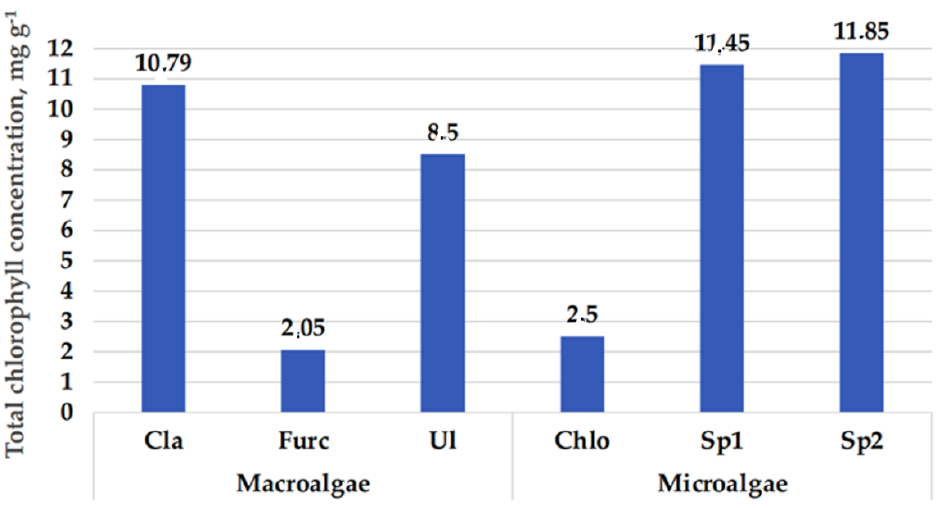
Figure 3. Total chlorophyll concentration (mg g − 1 ) in algal samples (Cla, Cladophora rupestris ; Furc, Furcellaria lumbricalis ; Ul, Ulva intestinalis ; Chlo, Chlorella vulgaris ; Sp1, Spirulina ( Arthrospira platensis ) from University of Texas; Sp2, Spirulina (Ltd. „Spila“).